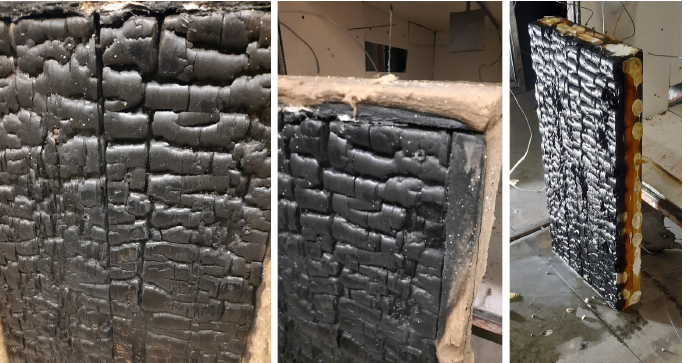
Figure 1. Timber panel after 30 min of ISO 834